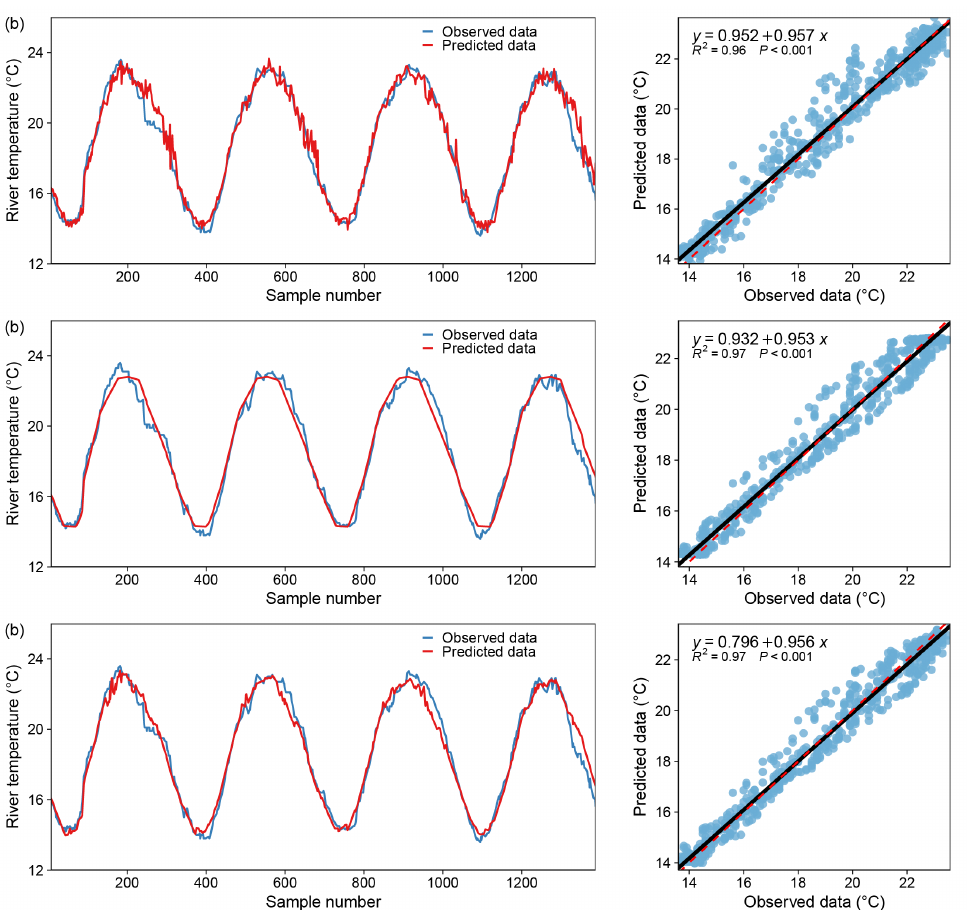
Figure 12. Model fitting results—Multilayer Perceptron Neural Network, blue dot: X coordinate (observed data), Y coordinate (predicted data) ; black line: y = x ; red dotted line: the regression curve of the blue dots. ( a ) only one input variable (DOY), ( b ) with two input variables (DOY and Flow), ( c ) with all